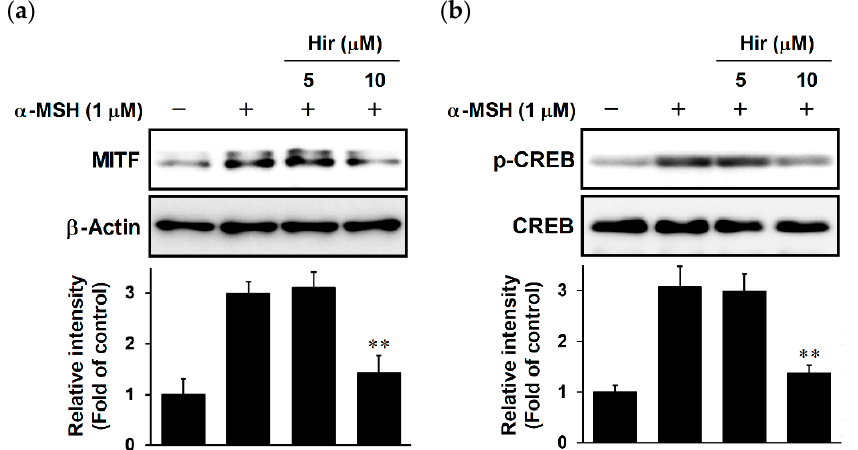
Figure 6. Effect of Hir on MITF expression and CREB phosphorylation in B16-F1 cells. The cells were treated with Hir at the indicated concentrations for 1 h, then stimulated with α -MSH for 24 h ( a ) or 30 min ( b ). Protein expression was determined using Western blotting as described in Materials and Methods. Band intensities were quantified using ImageJ software and normalized to the band intensities of β -actin ( a ) or CREB ( b ) as the internal control. The data shown are representative of 3–4 independent experiments. ** p < 0.05 versus α -MSH.